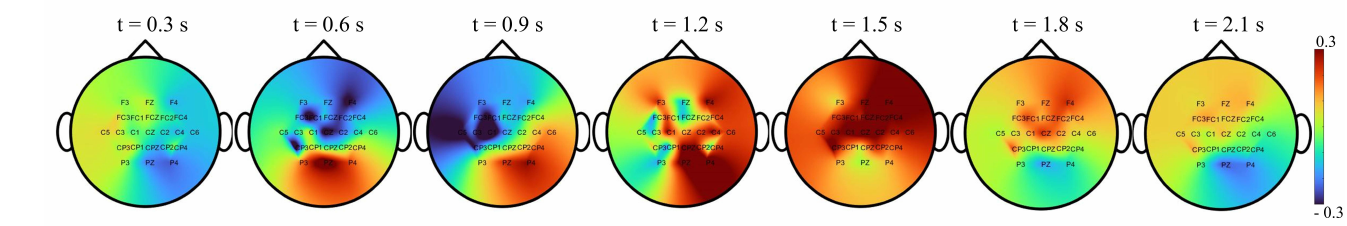
Figure 4. Dynamic neural activity changes during grasp. The averaged EEG activity amplitude from motor areas in all movement tasks. Post stimulus (t = 0 s) activity in the motor cortex first decreases after post-stimulus and then increases to peak during the movement (the color bar indicates the normalized amplitude of EEG